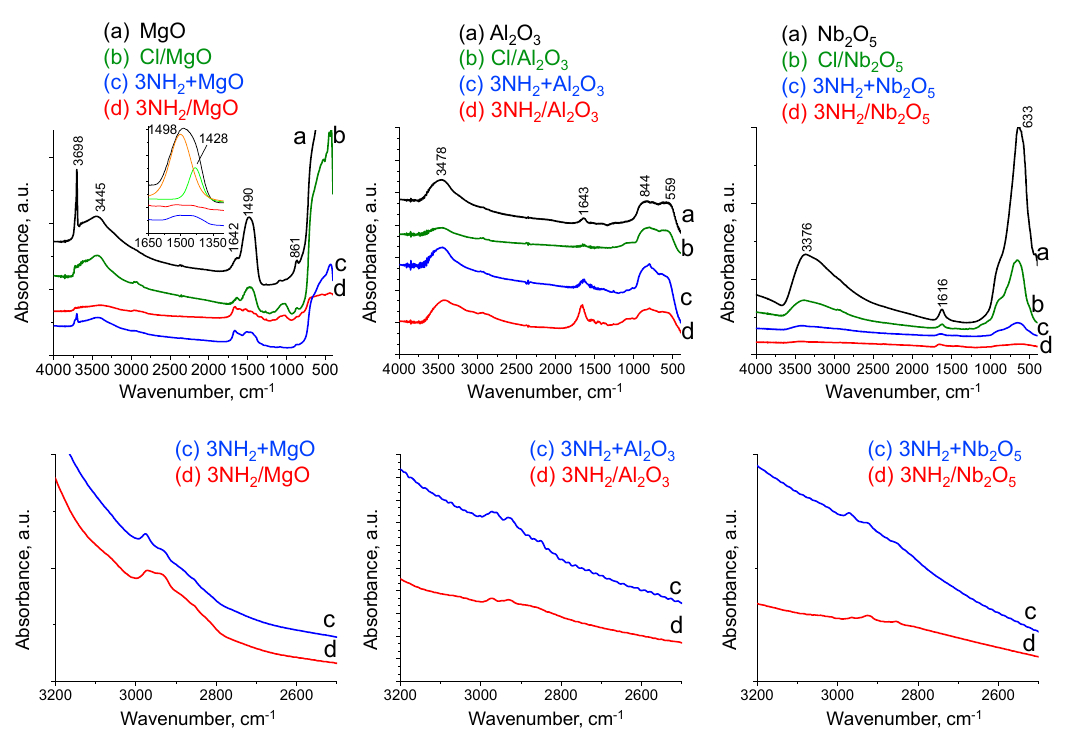
Figure 4. FTIR spectra before and after TAEA loading onto metal oxides. The analysed pills were prepared by mixing of 0.001 g of sample with 0.2 g of KBr.